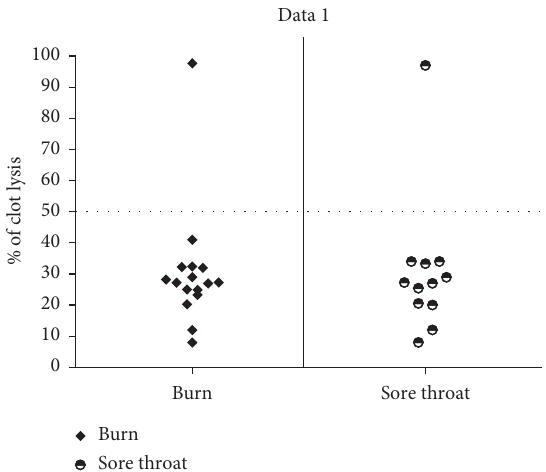
Figure 3: Percentage of clot lysis produced by S. pyogenes from different clinical sources.